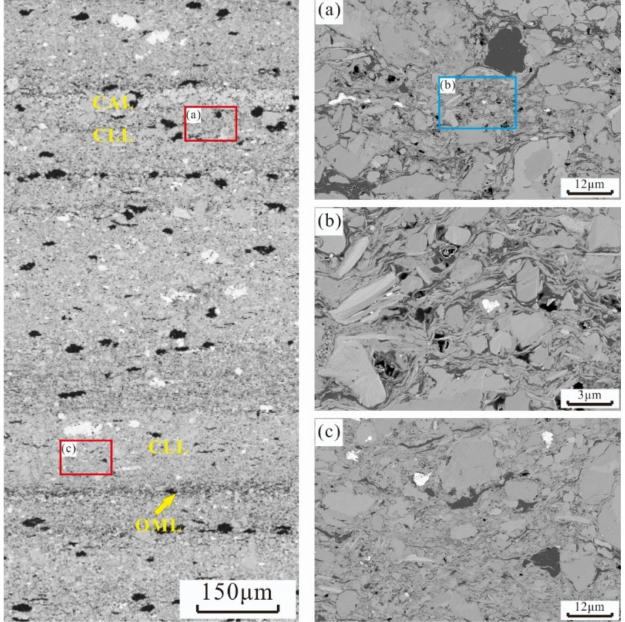
Figure 8. SEM images of CLL from Well G108-8 at 3212.64 m. ( a , c ) Magnification of CLL; ( b ) organic pores in CLL. CLL: clay laminae; CAL: carbonate laminae; OML: organic matter